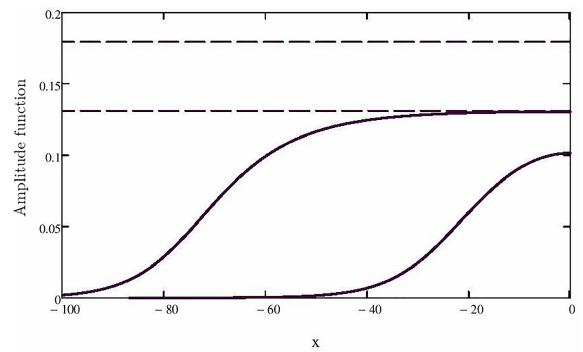
Figure 6. Profiles of stable solitary waves are shown by solid lines. Dashed lines correspond to A 2 = 0 . 1311 and A 1 = 0 . 1793. The limiting amplitude is reached when A 0 = A 2